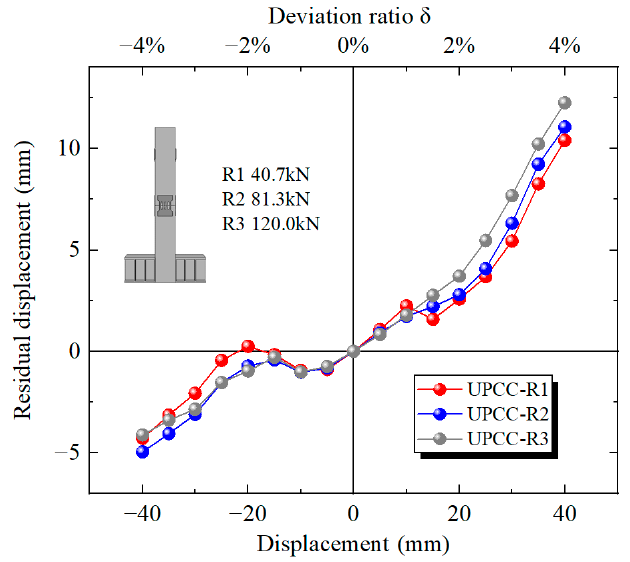
Figure 21. Residual displacement curves under different initial prestress. It can be seen from Figure 22 that with the increase in horizontal displacement from